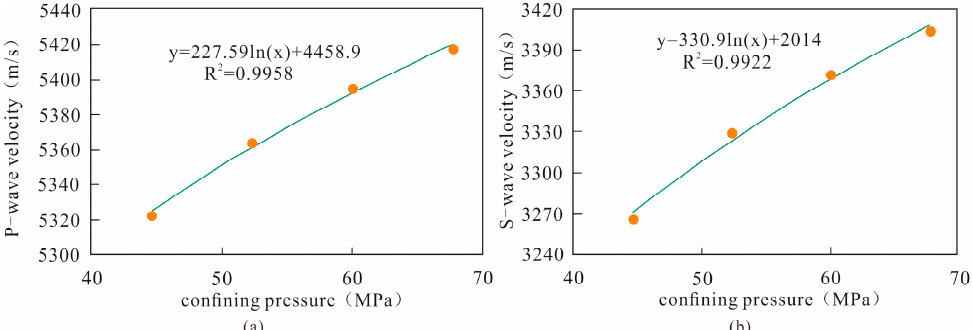
Figure 10. Curves of P − wave velocity, S − wave velocity and con fi ning pressure.